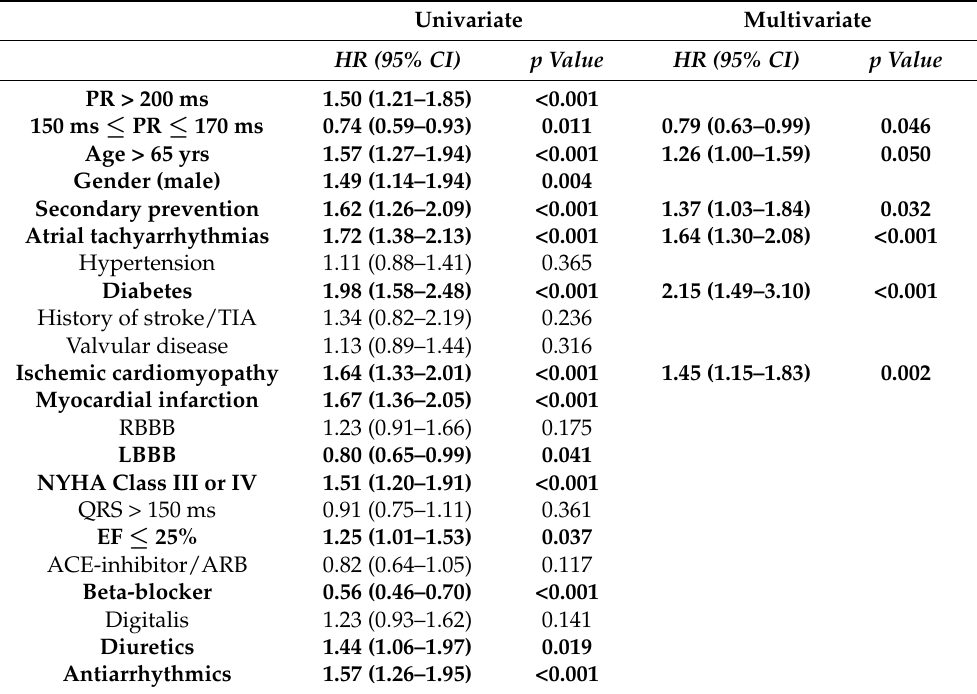
Table 3. Univariate and multivariate Cox regression analysis of the risk of all-cause death or HF